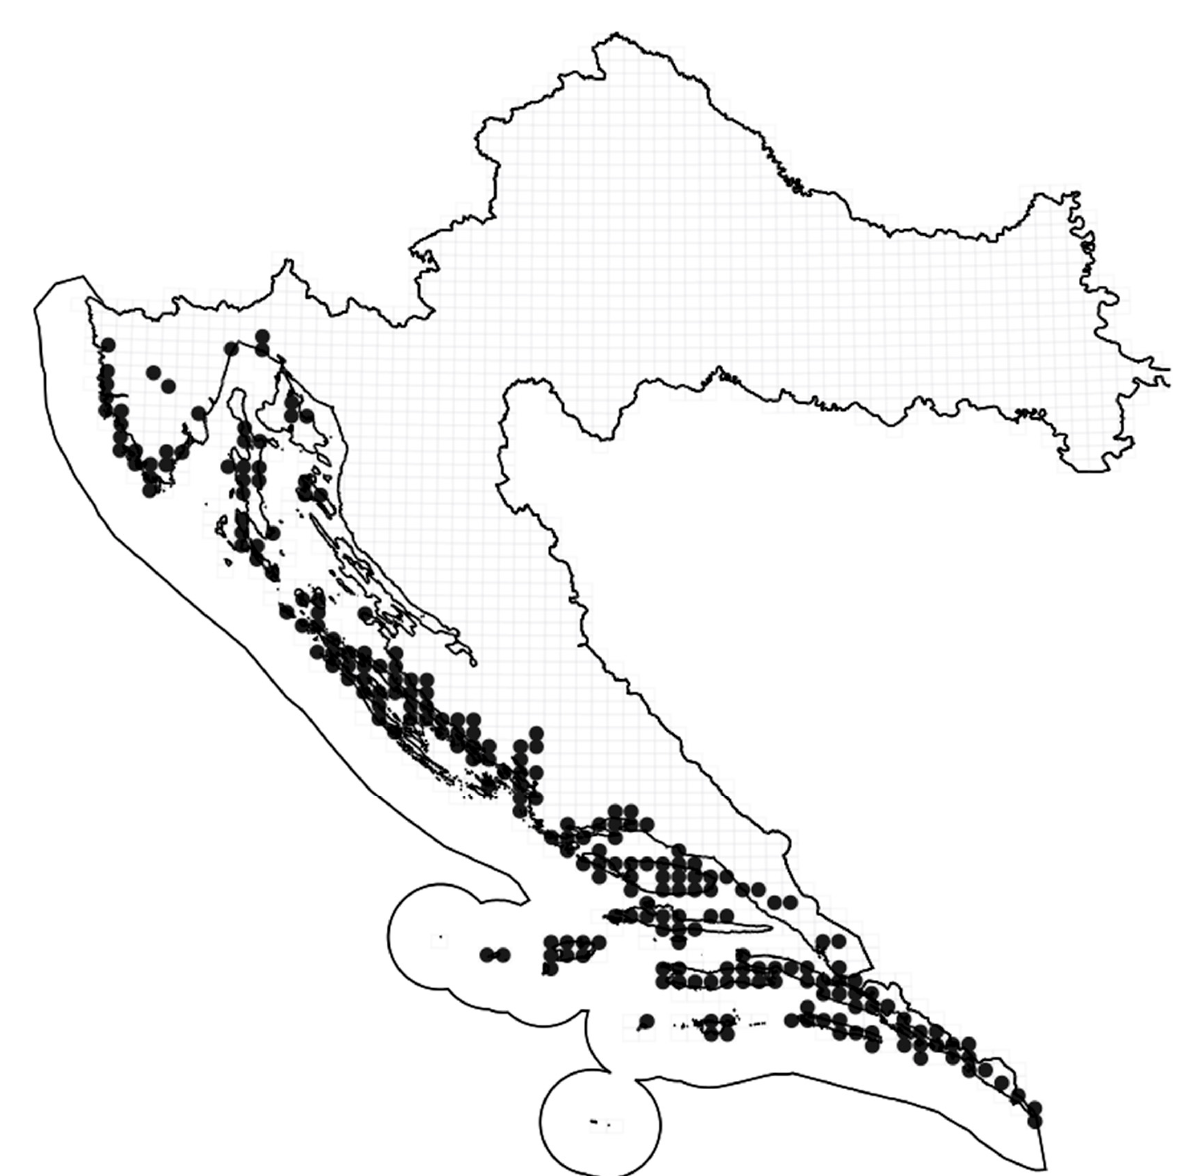
Figure 3. Distribution of wild plants of Arbutus unedo L. in Croatia according to the Flora Croatica Database [19].